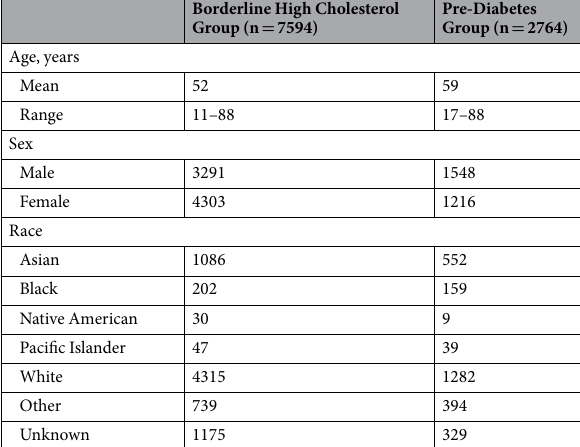
Table 2. Demographics of borderline high cholesterol and pre-diabetic cohorts. Age is at first pre-disease lab result.